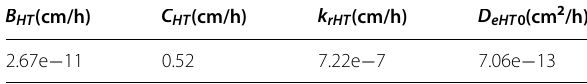
Table 2 Reaction coefficients of